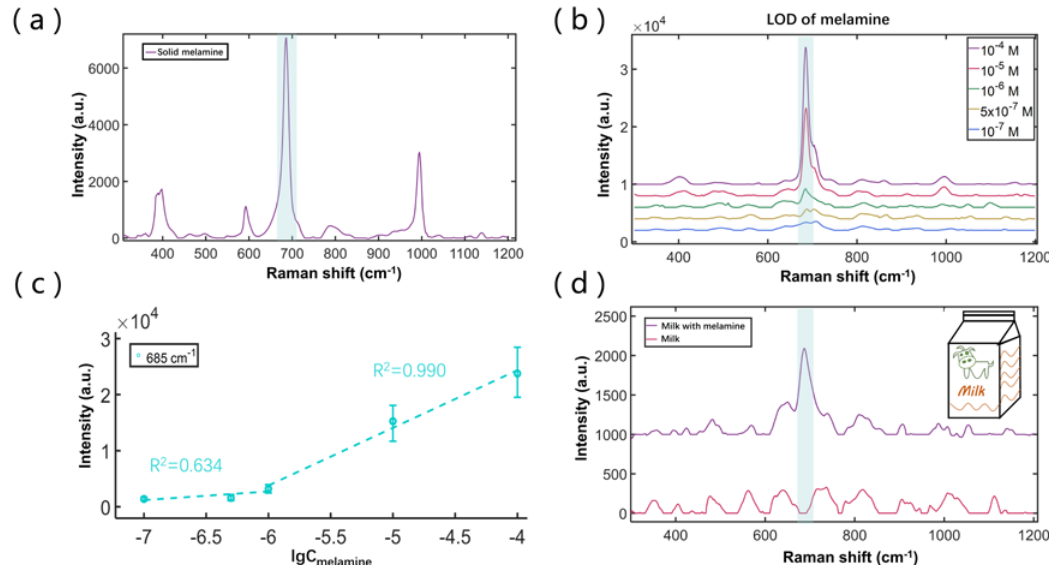
Figure 4. ( a ) Raman spectrum of solid melamine measured on the glass sheet; ( b ) SERS signals from dynamically enriching 13 μL droplet (10 μL melamine solution and 3 μL Ag colloid) with different concentrations; ( c ) data for SERS intensity peaks at 685 cm −1 versus melamine concentration; ( d ) Raman spectrum of pure milk and SERS signal of contaminated milk with melamine.